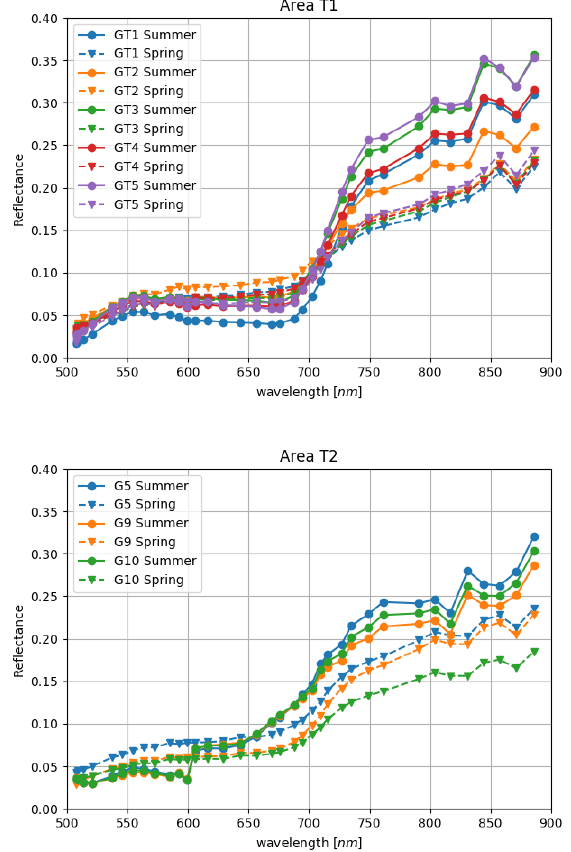
Figure 5. Reflectance spectra of sample plots. Top: area T1, bottom: area